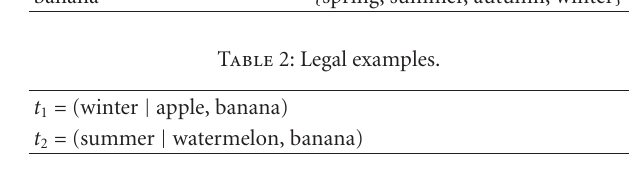
Table 3: Illegal